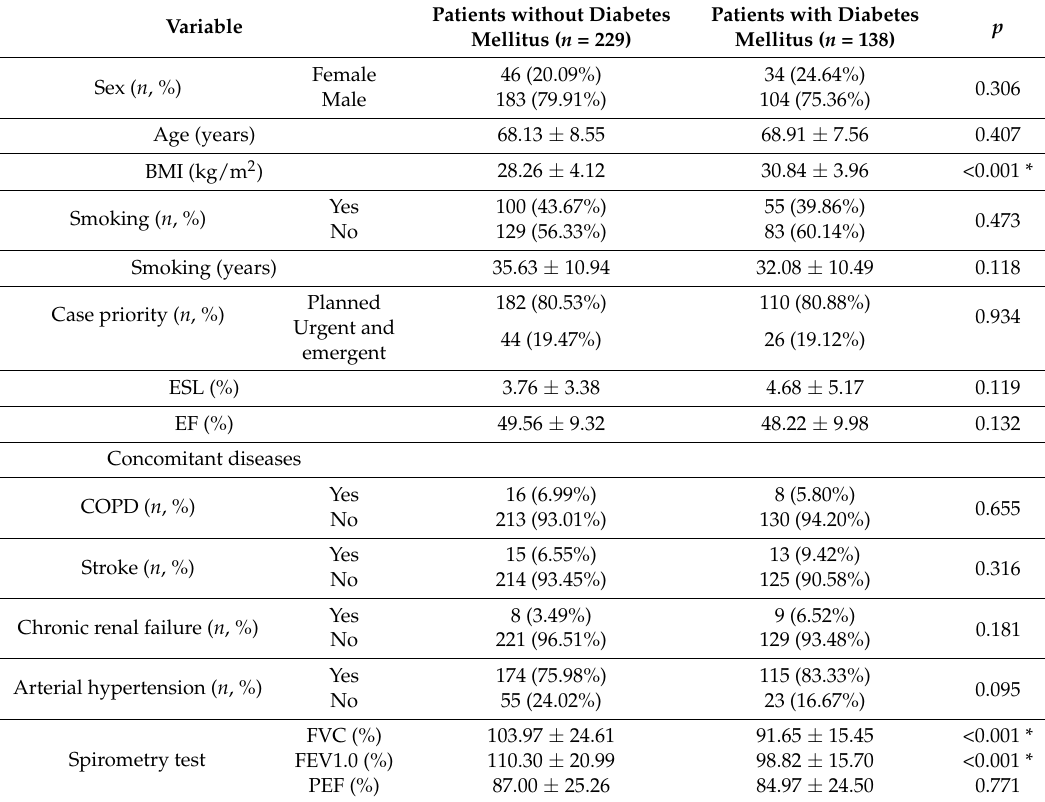
Table 1. Descriptive statistics of respiratory capacity in relation to the occurrence of diabetes mellitus. Patients without Diabetes Patients with Diabetes Variable Mellitus ( n = 229) Mellitus ( n =